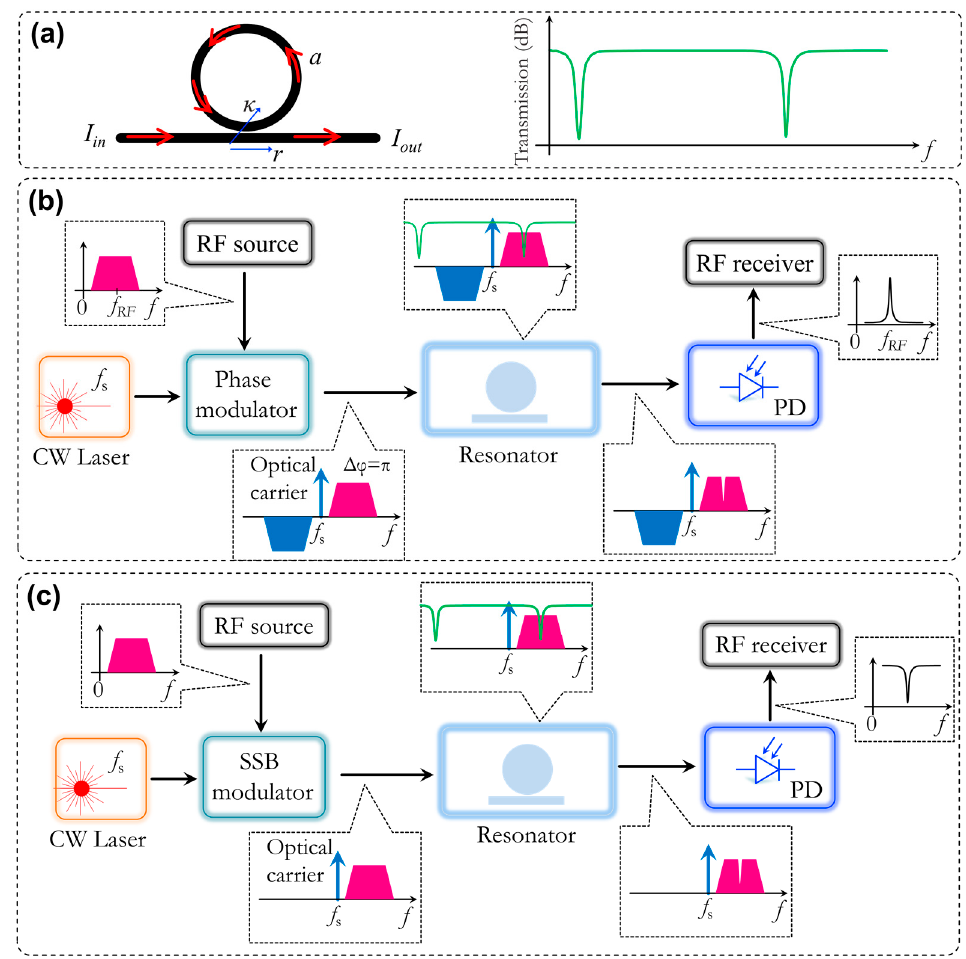
Figure 15. Operation concept of MPFs based on a single micro-resonator ( a ) All-pass micro-resonator and its power transmission spectrum. Schematic illustration of the schemes for ( b ) bandpass and ( c ) notch MPF implementations based on optical-to-RF mapping concept.